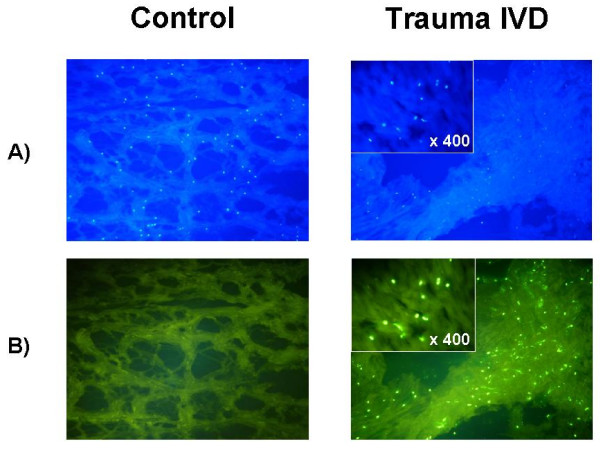
Trauma-induced IVD apoptosis. Large images displayed at × 100 magnification. A) DAPI staining positive for IVD cells in the disc tissue matrix (control (left panel) versus trauma (right panel)). B) TUNEL staining demonstrates positive DNA fragmentation of IVD cells in the trauma IVD tissue sample (right panel) versus the negative control tissue (left panel).